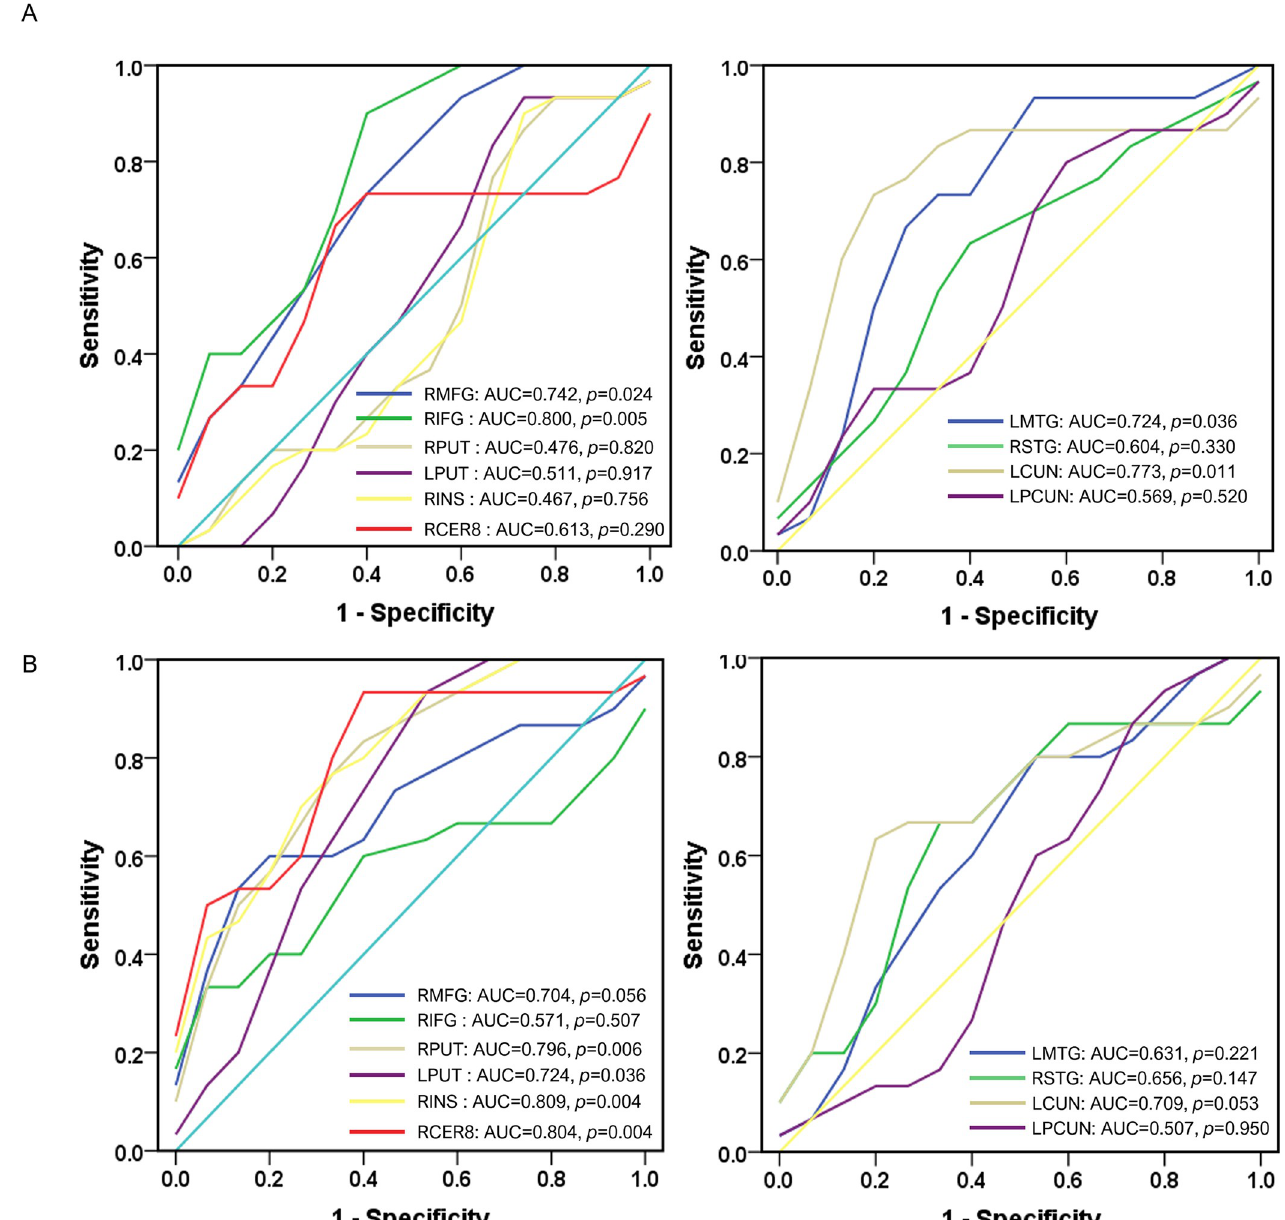
Fig 4. Correlations between morphometrics and neurocognitive scores in PD patients with MCI. (A) Gray matter volume of right middle frontal gyrus was positively correlated with MOCA scores; (B) Cortical thickness of right superior temporal gyrus was negatively correlated with MMSE scores. MFG, middle frontal gyrus; STG, superior temporal